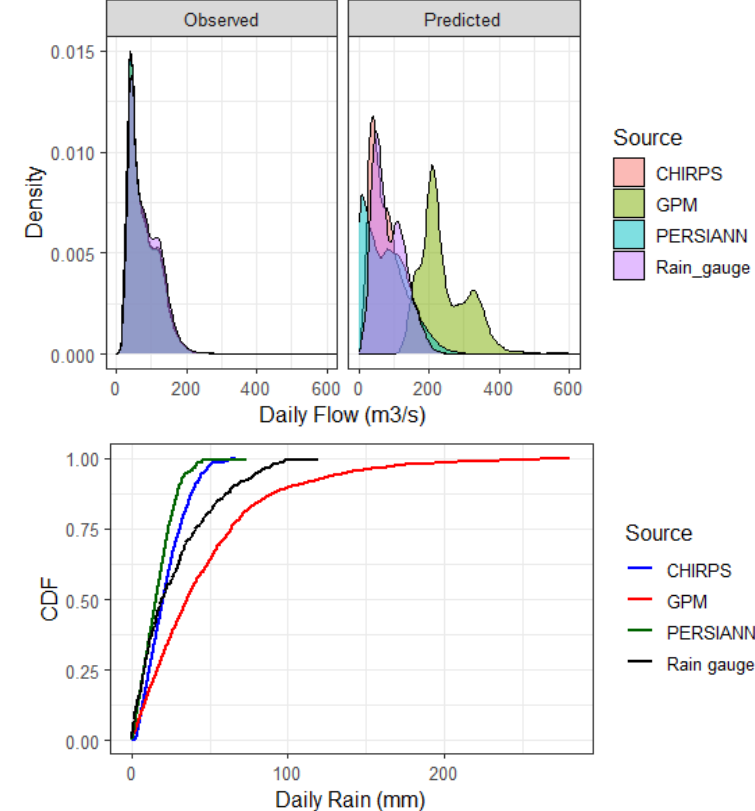
Figure 10. Probability density function (PDF) of observed and predicted daily flow ( A ), Cumulative density function of rainfall input ( B ).